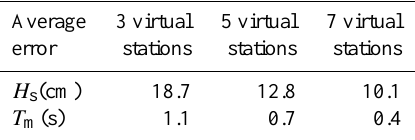
Table 3. Average errors of significant wave heights and mean wave periods for different virtual